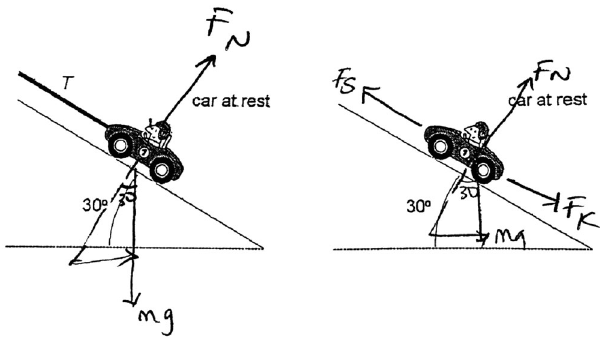
FIG. 4. An example of the different FBDs drawn for the tension problem (left) and the friction problem (right) by the same student. This student mistakenly included an additional force — the kinetic friction — in the FBD for the friction problem.